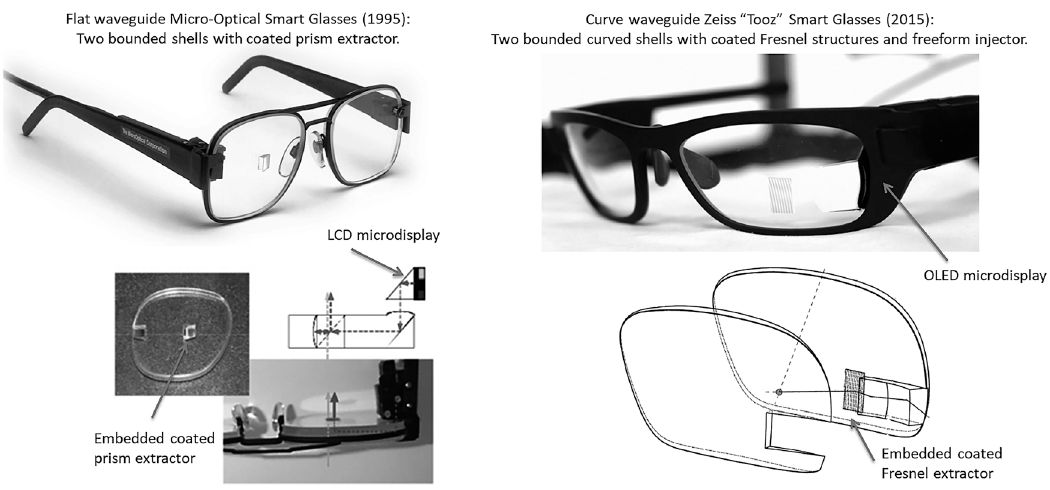
Figure 6: Zeiss “ Tooz ” smart glass with single exit pupil allowing for curved